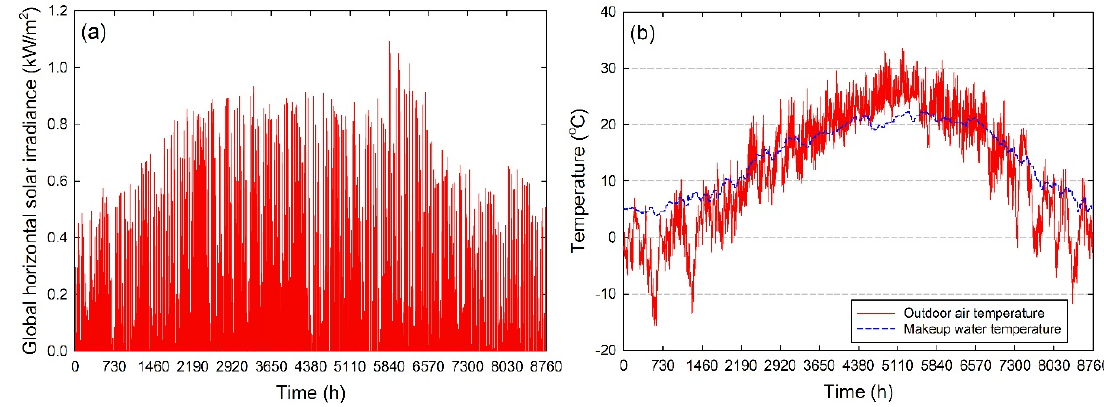
Figure 4. ( a ) Hourly global horizontal solar irradiance; and ( b ) outdoor air temperature and make-up water temperature over one year for Incheon, South